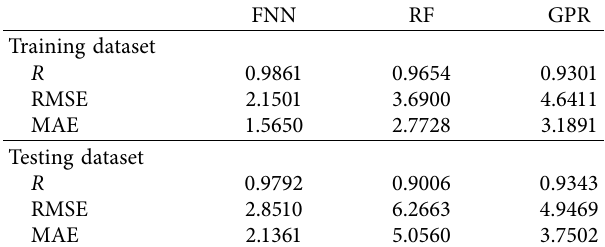
Figure 10: Regression graphs for the training and testing datasets for (a) RF algorithm and (b) GPR algorithm. Table 4: Performance analysis of FNN, RF, and GPR